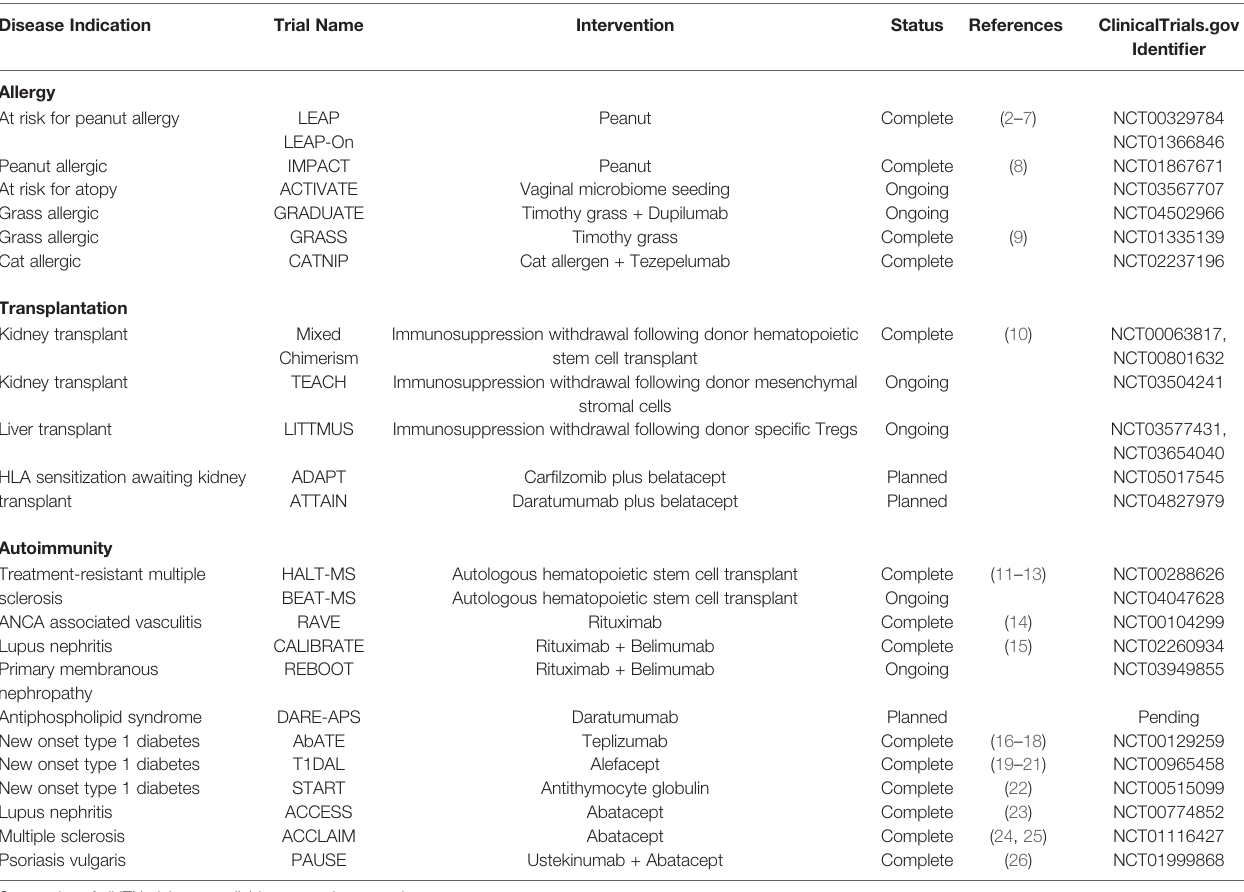
TABLE 1 | Summary of ITN Clinical Trials Included in this Review.